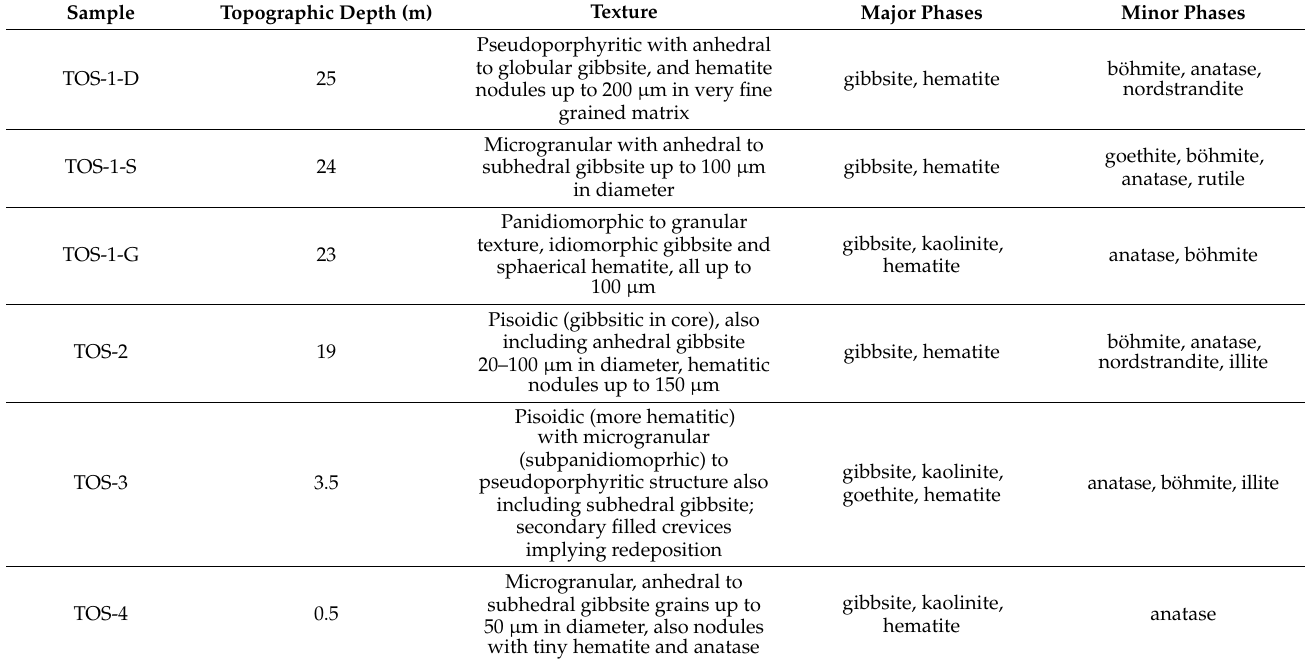
Table 1. Textural (after [17]) and mineralogical properties of the bauxite samples investigated in the Toši´ci-Duji´ci deposit. Sample Topographic Depth